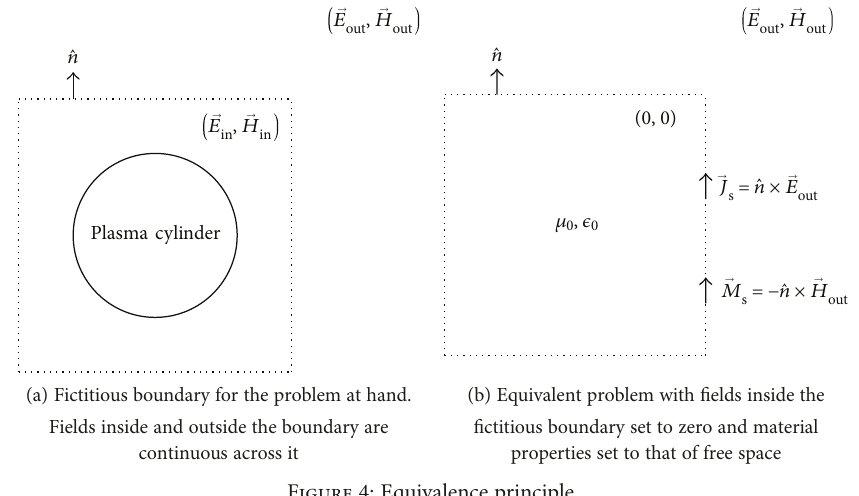
Figure 4: Equivalence